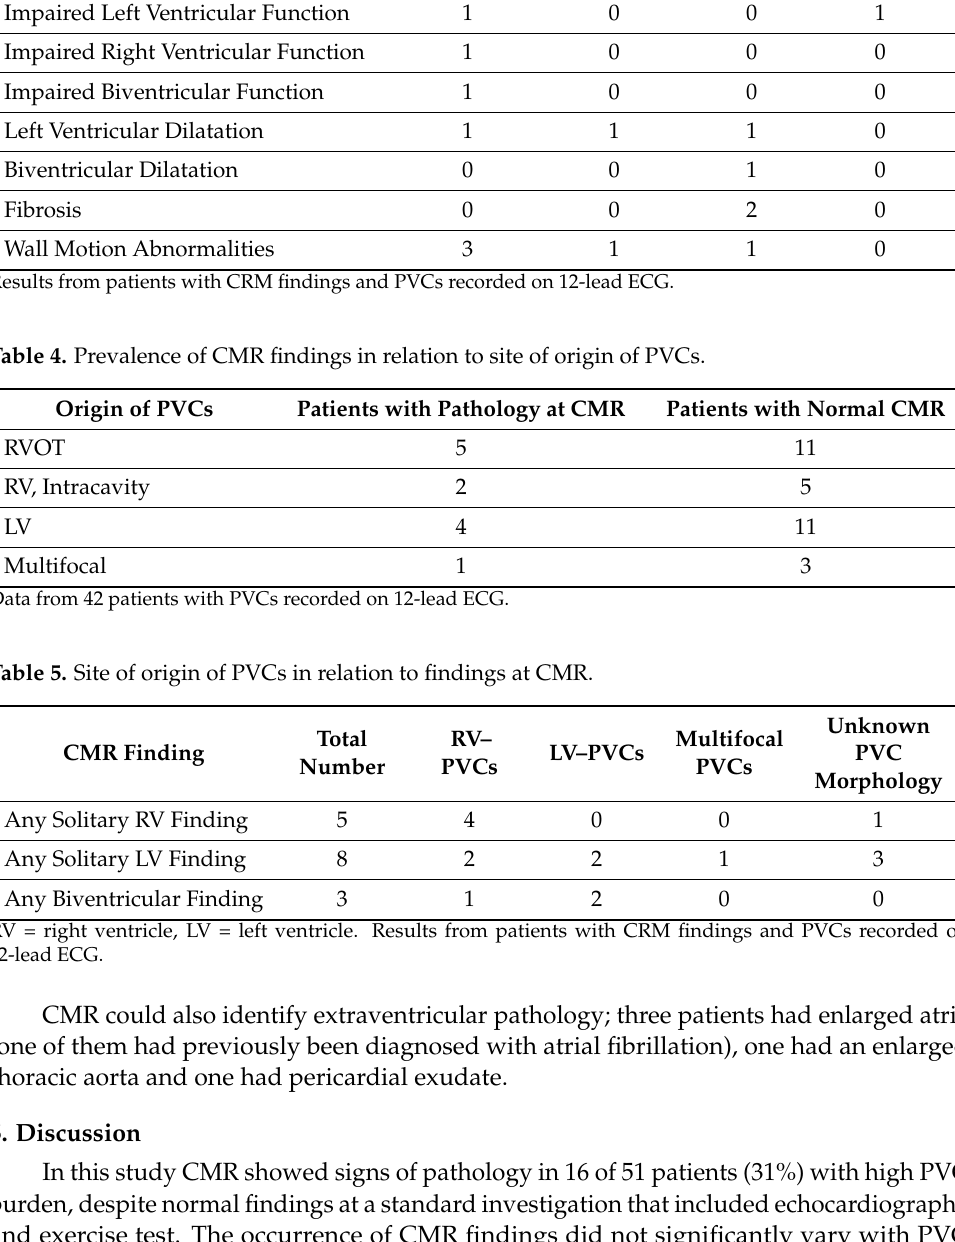
Table 3. Site of origin of PVCs related to CMR findings. CMR Finding RVOT RV, Intracavity LV Multifocal Impaired Left Ventricular Function Impaired Right Ventricular Function 0 0 0 Impaired Biventricular Function 1 0 Left Ventricular Dilatation